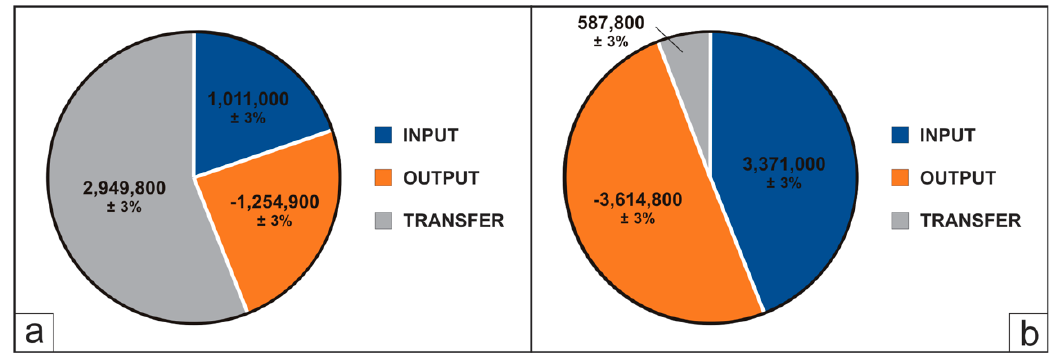
Figure 8. The plots show the contributions of input, output and transfer (expressed in m 3 ) to the anthropogenic sediment budget in the 1980–2020 timespan. ( a ) sediment redistribution activities within the limit of the study area are considered as transfers; ( b ) sediment transfers between different sub-cells are considered as inputs and outputs.